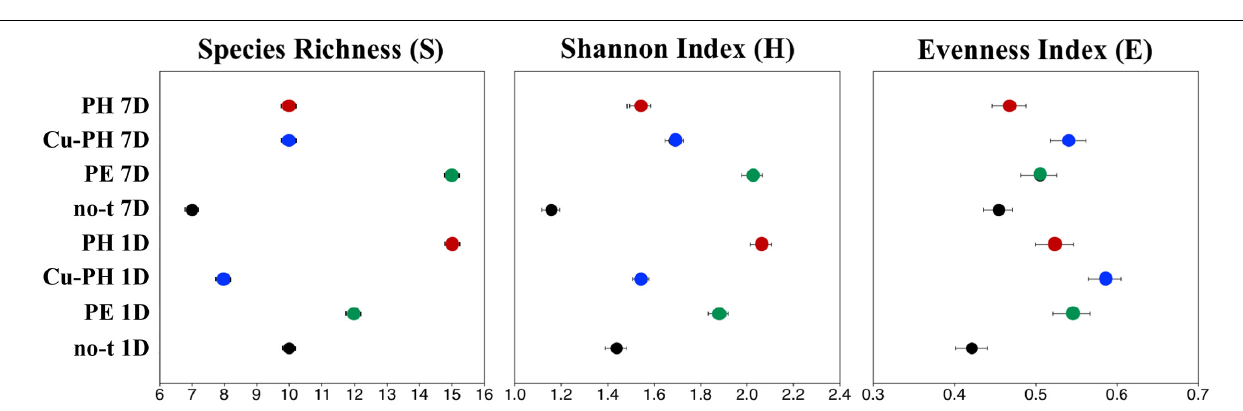
Frontiers in Plant Science |